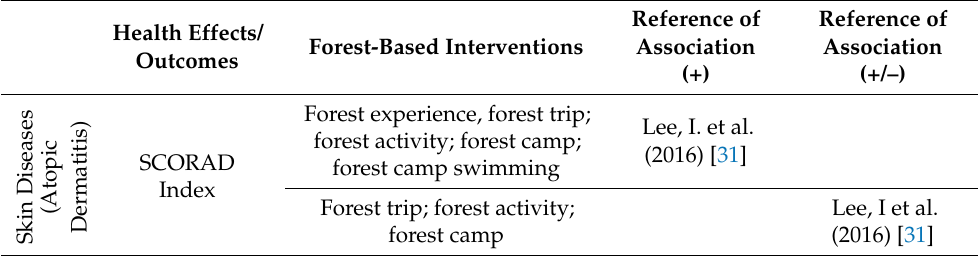
Table 6. Summary of associations between forest-based interventions and health effects/outcomes in atopic